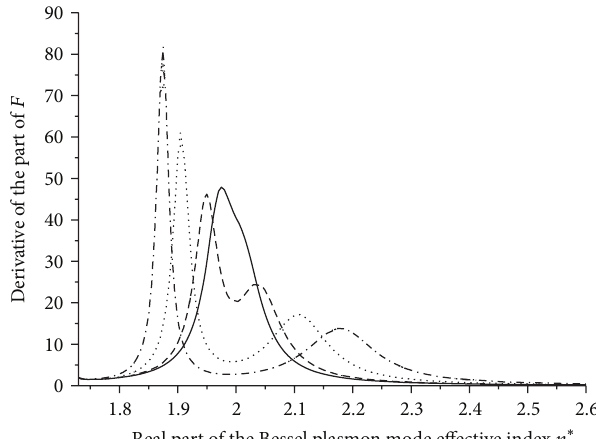
Figure 6: The derivative of the phase of 𝐹 function versus the real part of Besselsurfaceplasmon polariton modeeffective index for the gold film of 50 nm (—), 30 nm (- - -), and 20 nm ( ⋅⋅⋅ ) embedded in ZrO 2